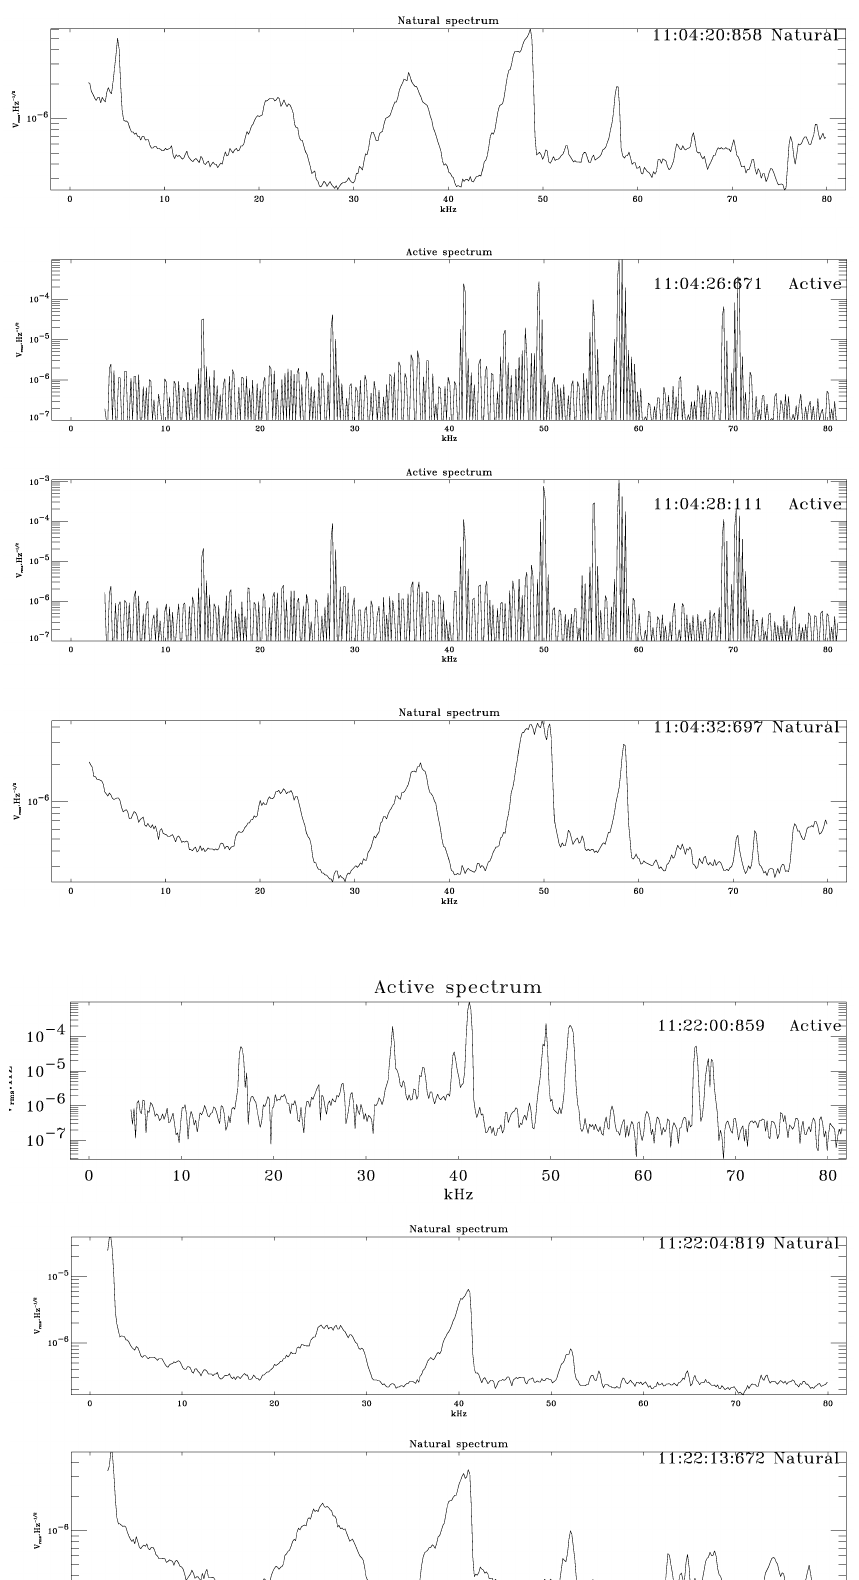
Fig. 9. Consecutive active and passive spectra collected at 11:22UT. Fp and Fuh are seen as low amplitude reso- nances below the strong Fq . The nat- ural emission lies between Fp and Fq